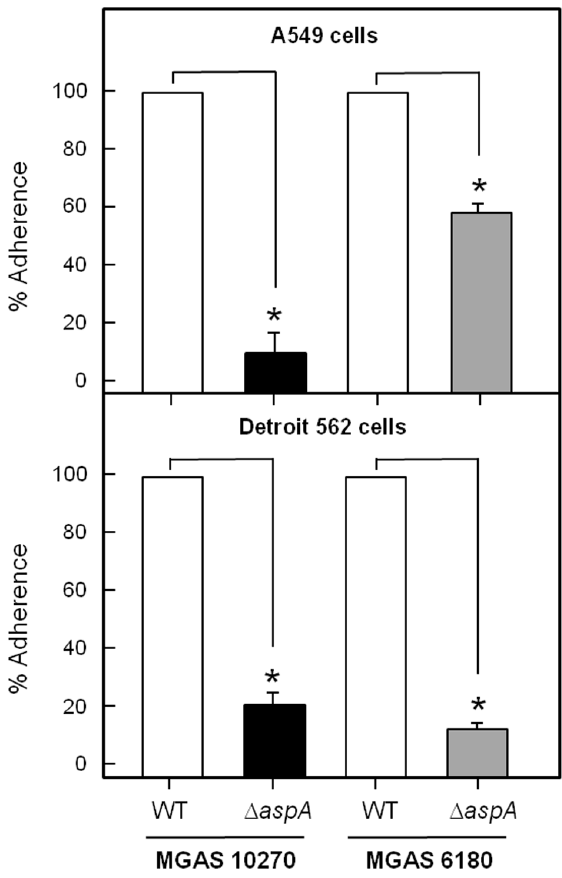
Figure 3. Adherence levels of MGAS10270 or MGAS6180 and corresponding D aspA mutants to A549 lung epithelial cells (pneumocytes) or Detroit 562 pharyngeal epithelial cells. Adherence is expressed as percentage of input cells (10 6 cfu) attached. Data are means 6 SEM of 3 experiments repeated in triplicate. *= P , 0.001 using 2 tail student T-test.